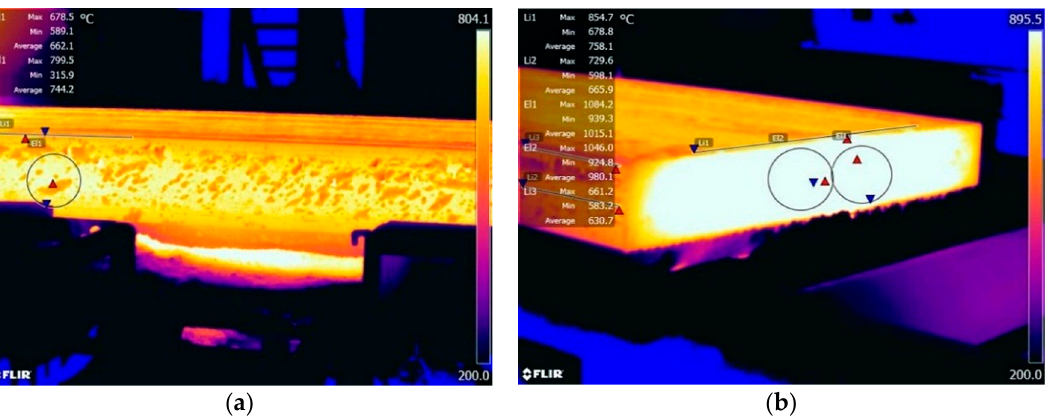
Figure 2. Infrared images collected by FLIR SC620 on the producing spot: ( a ) the exit of continuous caster and ( b ) the position after flame cutting.